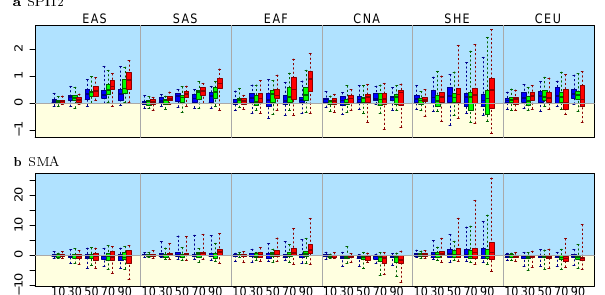
Fig. 7. Wetting regions in the 21st century. (a) Box plots for 20yr average SPI12, regions where the median SPI12 increases. The numbers at the bottom-most x-axis denote the central years in the 21st century of the 20yr windows. Colours indicate the respective GHG concentrations scenario, blue: RCP2.6, green: RCP4.5 and red: RCP8.5. (b) like (a) , but for Soil Moisture Anomalies (SMA). Changes are given as standard deviations with respect to 1979–2009 in both